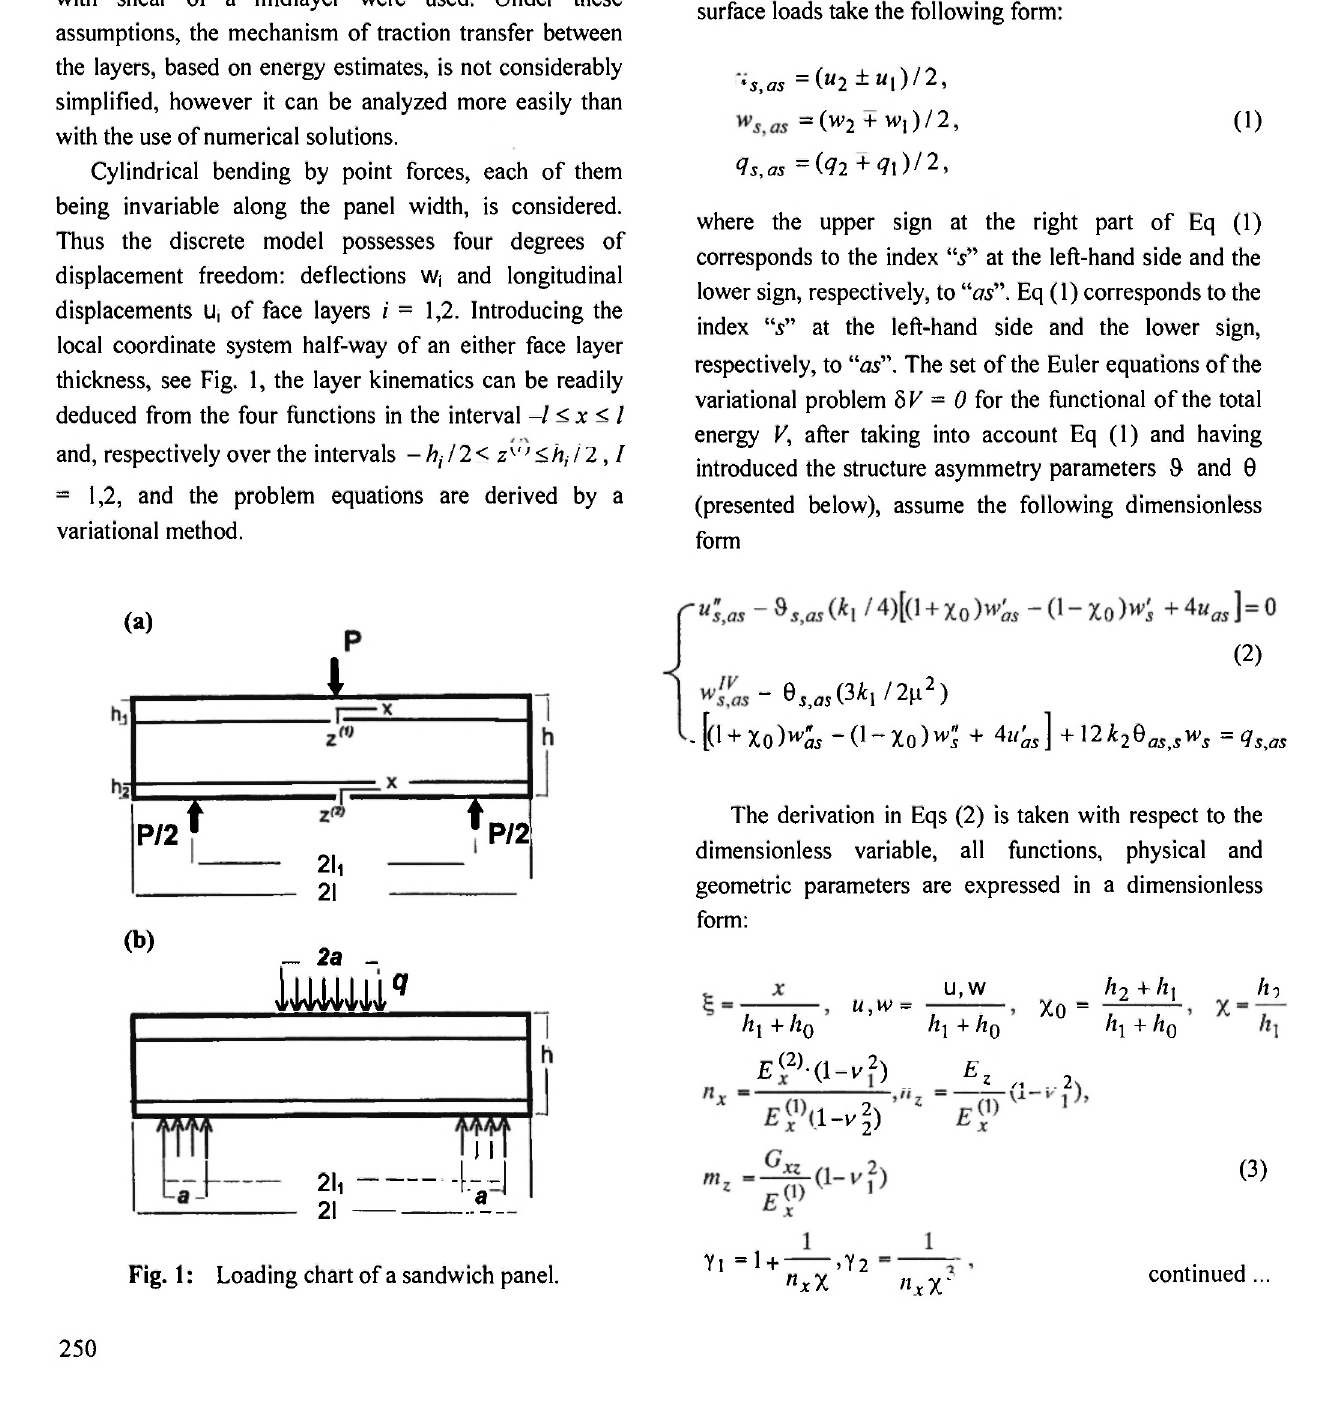
Fig. 1 : Loading chart of a sandwich